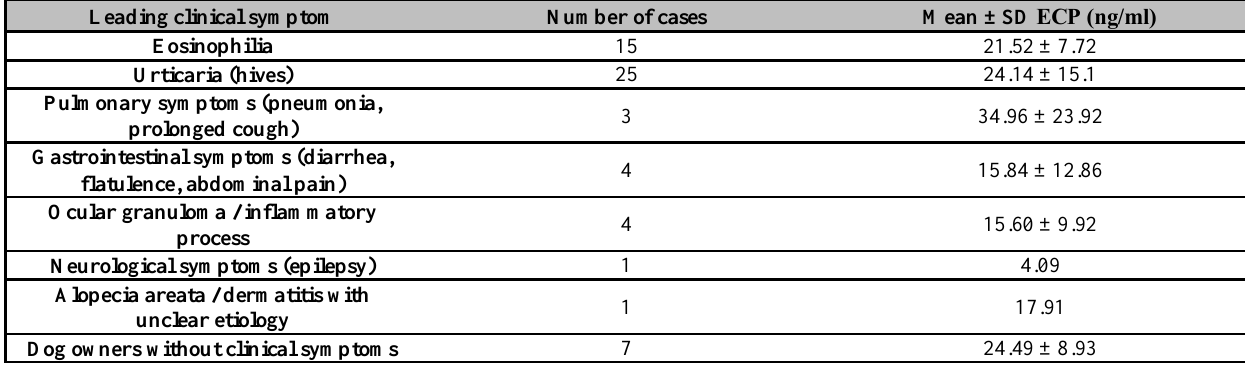
Table 2. ECP concentration (ng/ml) in patients with toxocariasis according to the leading clinical symptom Leading clinical